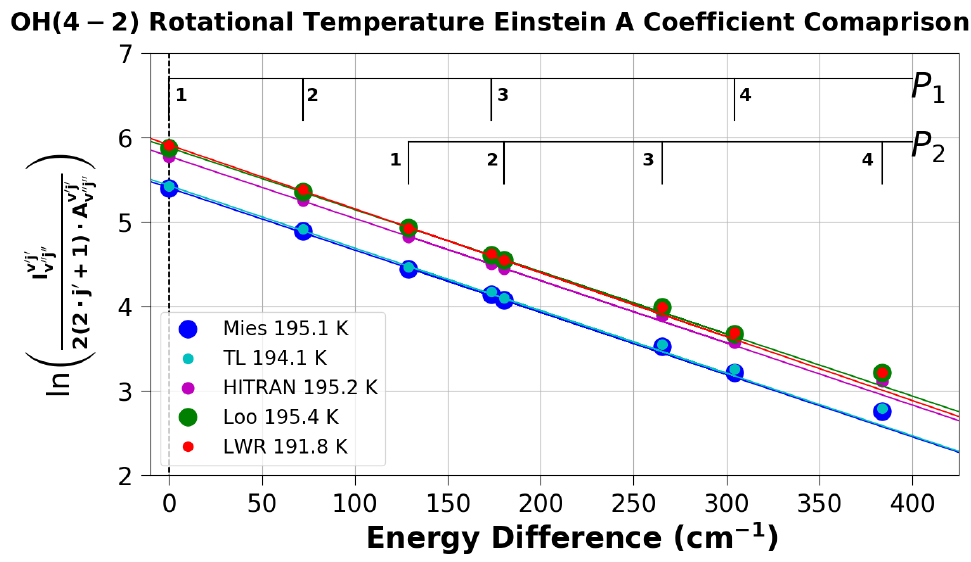
Figure 4. The rotational temperature measurements of the median OH ( 4 − 2 ) spectrum in Figure 1 calculated using the Einstein A coefficients from Mies, TL, HITRAN, Loo, and LWR. The rotational temperatures were calculated using the N (cid:48) ≤ 2 emission lines of the P 1 and P 2 branches.